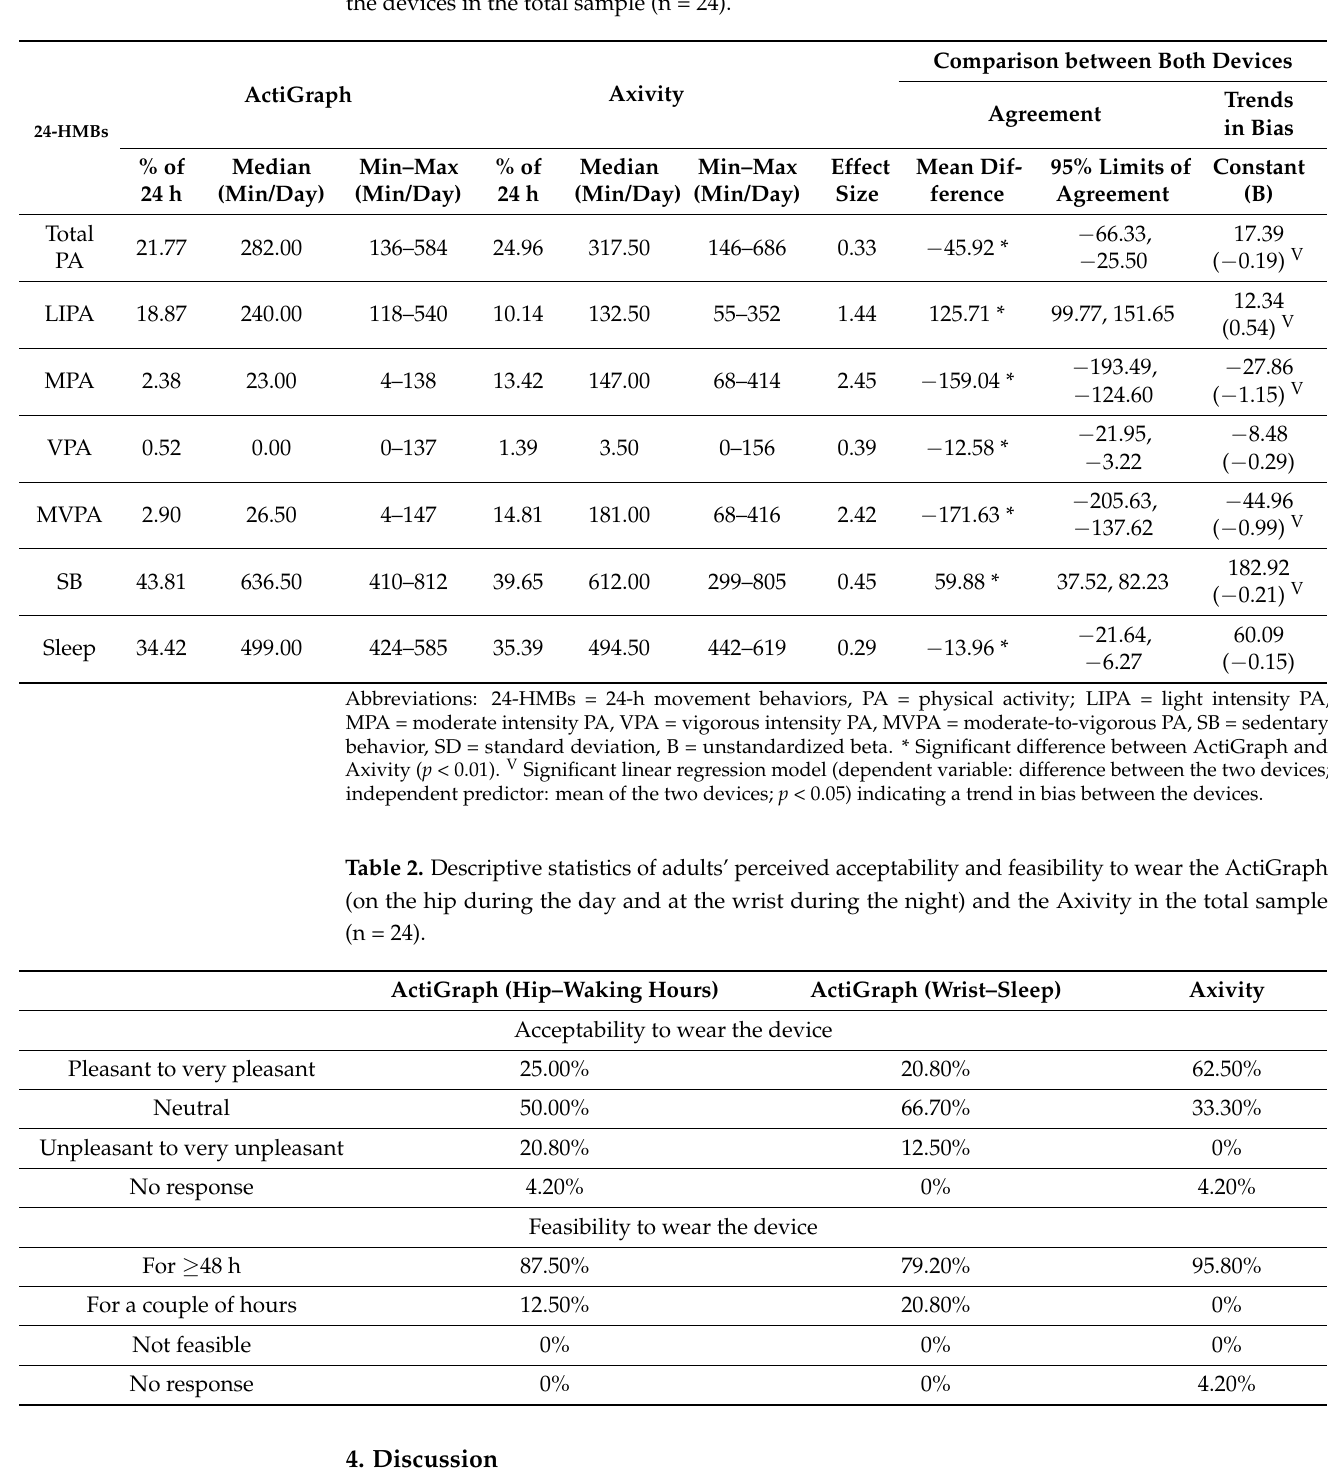
Table 1. Bland–Altman analyses for agreement between the ActiGraph and Axivity defined mean time in 24-h movement behaviors and linear regression analyses to investigate trends in bias between the devices in the total sample (n = 24).